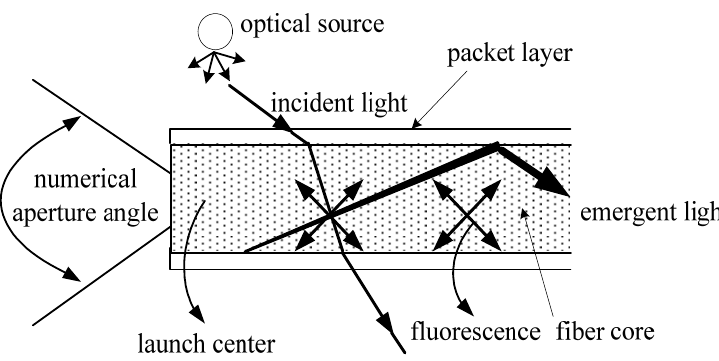
Figure 1. Optical signals received by fluorescent